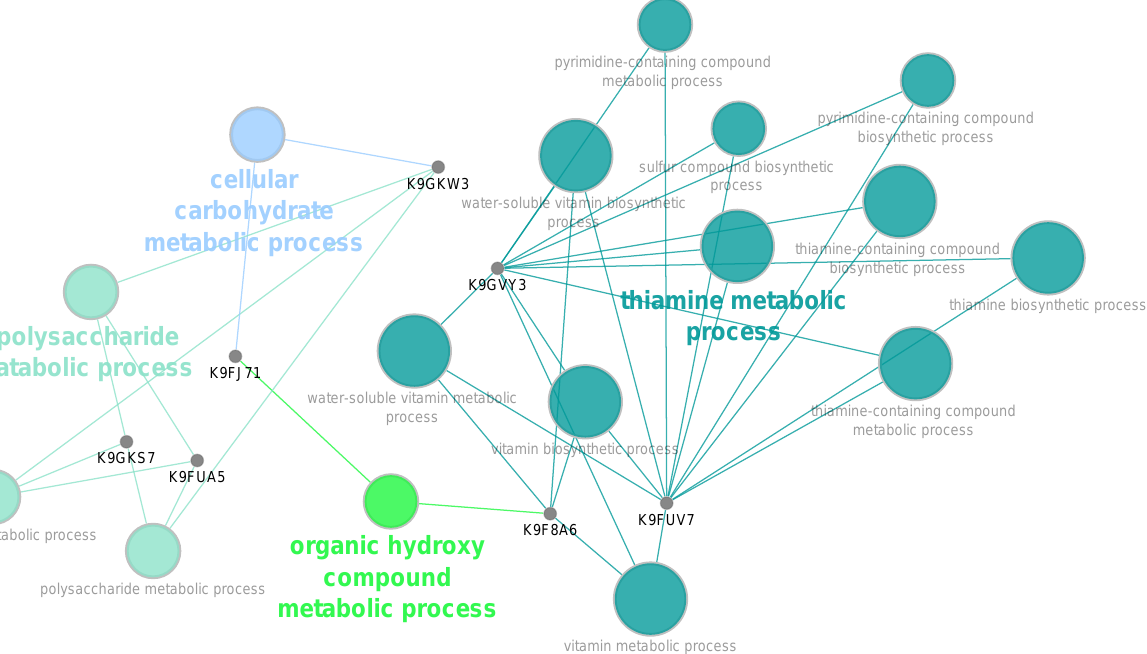
Figure 4. Functionally grouped network of enriched molecular function categories for a subset of differentially expressed proteins generated using the ClueGO Cytoscape plug-in. The proportion of shared proteins between terms was evaluated using kappa statistics. GO terms are depicted as nodes whose size represents the term enrichment